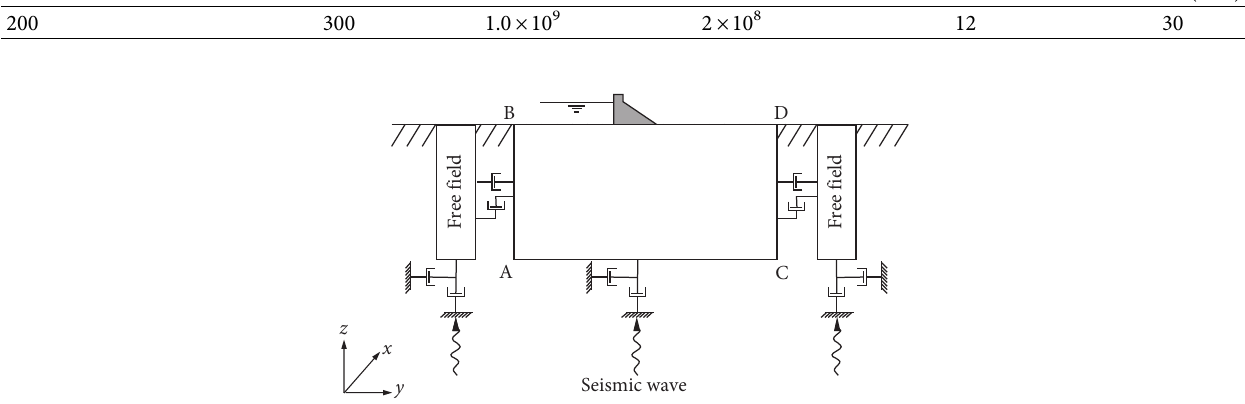
Figure 7: Model for seismic analysis of surface structures and free-field mesh.